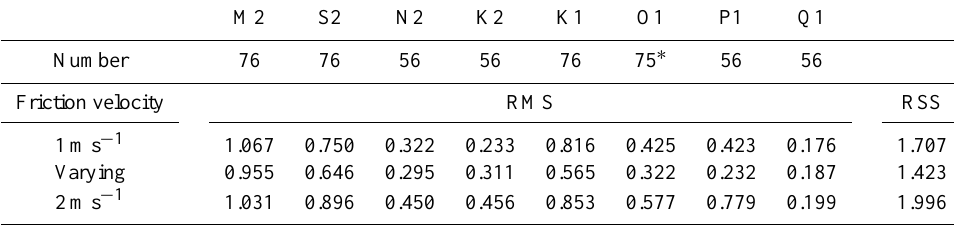
Table 6. RMS and RSS of the differences between the solutions using different friction velocity and the observations. Unit iscm.